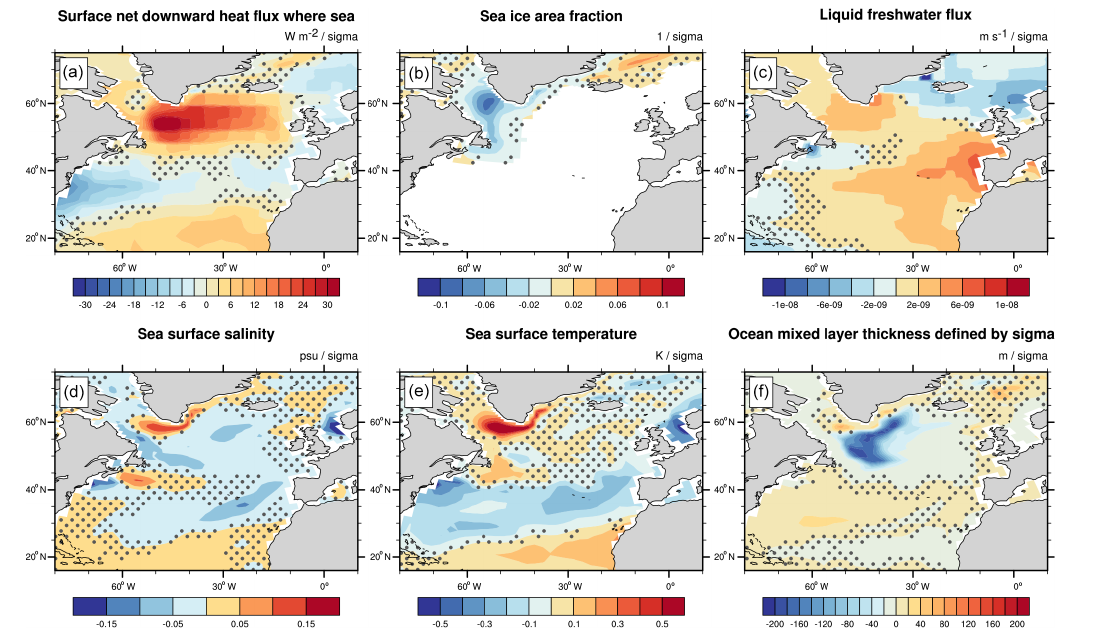
Figure 8. Influence of a negative AO phase on different oceanic variables in CTRL_CHEM during winter (November–March). Linear regression coefficients for (a) net downward heat flux, (b) sea ice area fraction, (c) liquid freshwater flux (evaporation minus precipitation), (d) sea surface salinity, (e) sea surface temperature, and (f) mixed layer depth. To highlight the influence of a negative AO phase, the AO index has been reversed in the regression analysis. Dots denote non-significant temperature differences (Student’s t test, p >